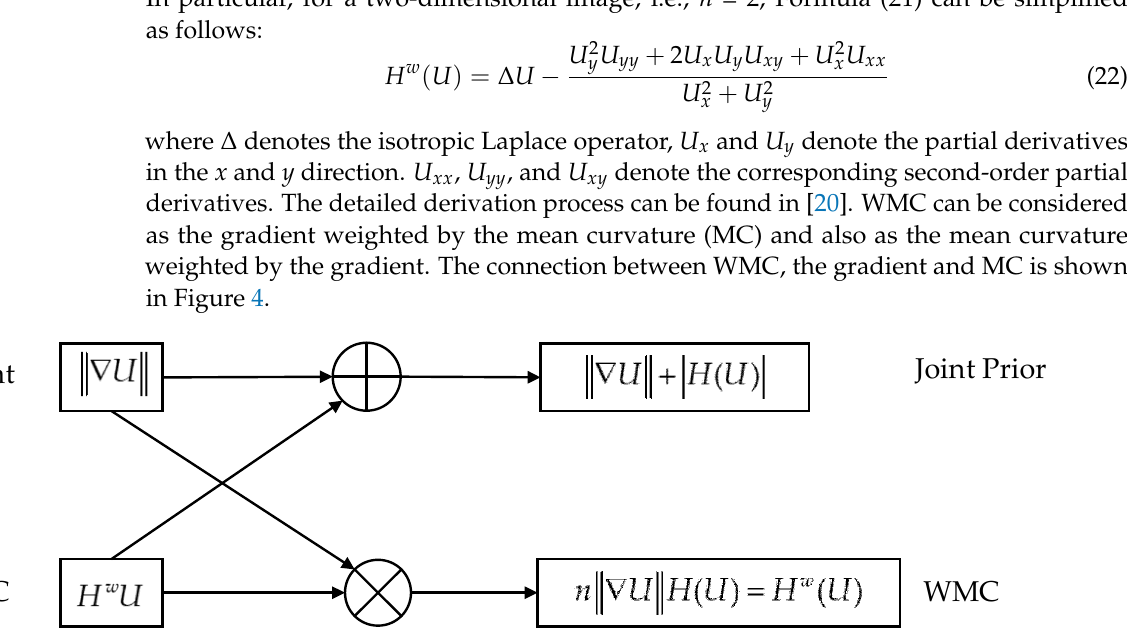
Figure 4. The connection between ∆ U , H ( U ) and H w ( U ) .